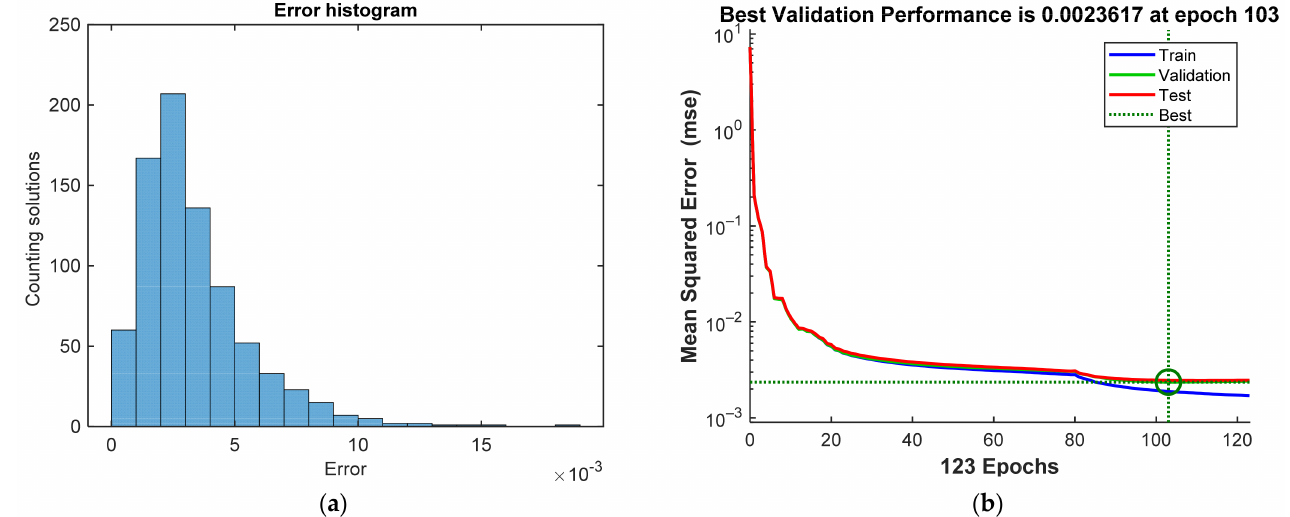
Figure 12. ( a ) The correctional NN error propagation histogram ( b ) The performance of the correc- tional